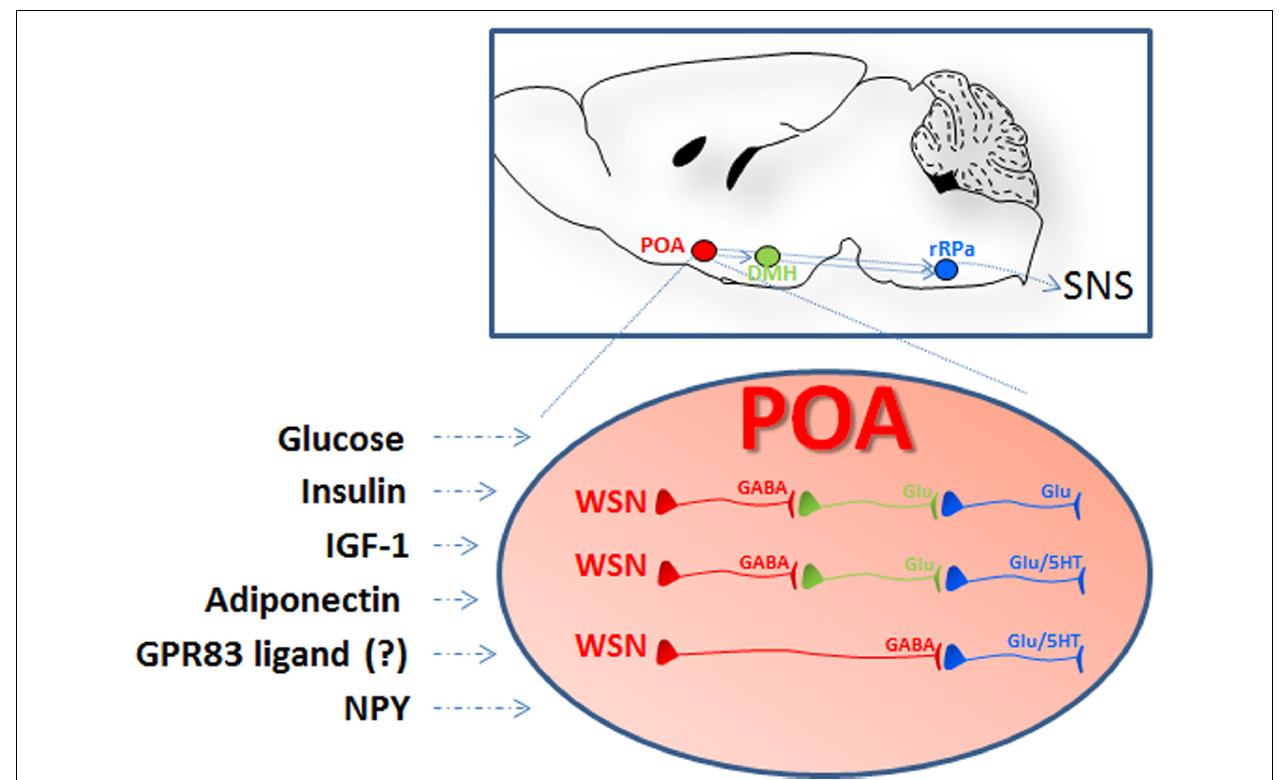
these ligands, as well as GPR83, were demonstrated in the POA warm-sensitive neurons (WSN).These specialized GABAergic cells exert a tonic inhibition on the raphe pallidus (aRP) either directly or through neurons in the dorsomedial hypothalamus (DMH) and control thermogenesis by activation of brown adipose tissue (BAT), muscular shivering, or the regulation of vasodilation (scheme adapted from Morrison and Nakamura, 2011).WSN are one component of the POA thermoregulatory neurocircuitry that comprises also temperature insensitive and cold-sensitive neurons that might also participate in the POA responses to nutrients (not shown in this